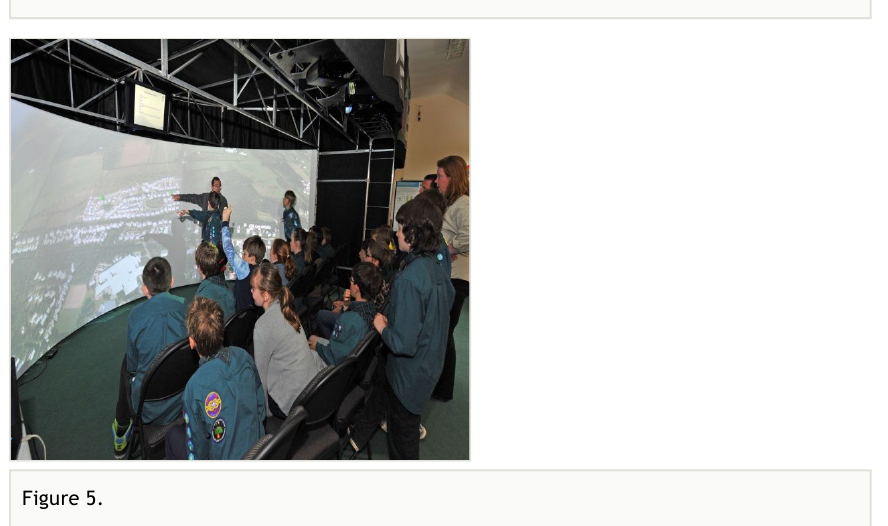
Stakeholder groups included policy-makers, land managers, foresters and farmers, the public, and young people under 20 years of age. Semi-structured group discussions were run with stakeholders voting on ES under each scenario, recording their values for di ff erent land use changes: woodlands, renewable energy, transport, housing, access, recreational facilities, and protection or enhancement of habitats, water quality and landscapes. Findings from the Tarland Basin study indicated positive values for landscapes with a visible mix of land uses, sound stewardship, elements of perceived naturalness and visual diversity (consistent with the fi ndings of Ode et al. 2009). From consultation events, commonality between audiences showed high values for amenity woodland adjacent to the